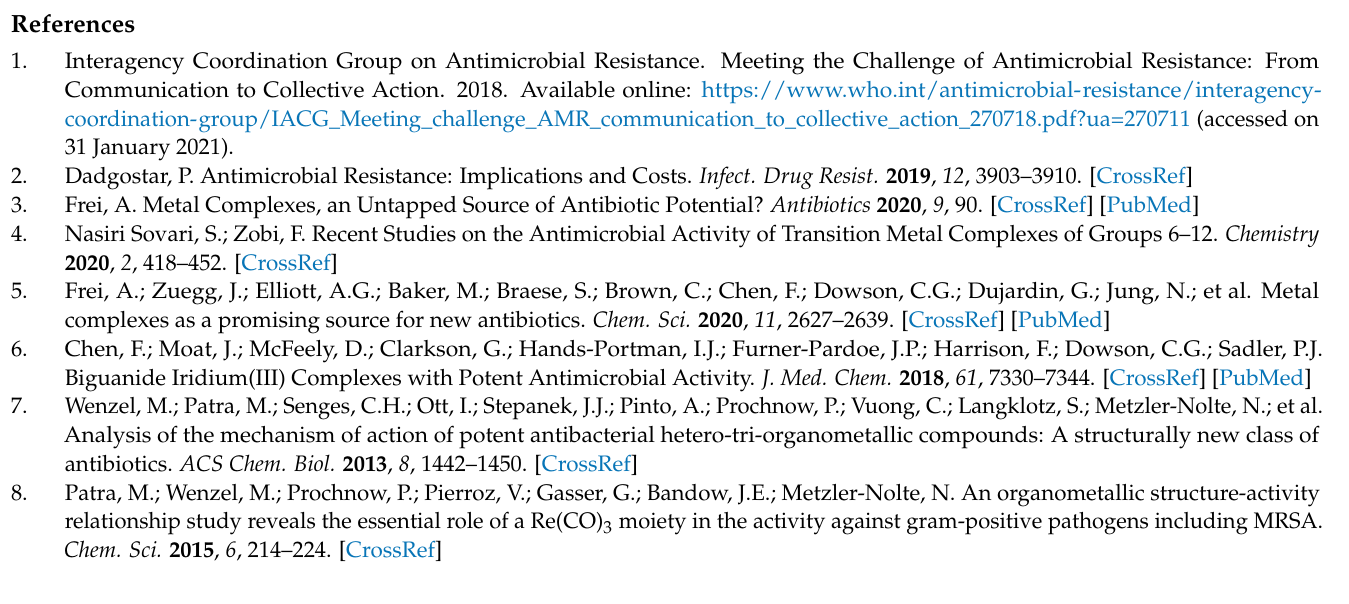
Figure S32: UV-Vis spectrum of [Re(CO) 3 (bpy)(O 2 CBz)] ( 10 ) in DMF, Figure S33: UV-Vis spectrum of ( 12 ) in DMF, Figure S35: UV-Vis spectrum of [Re(CO) 2 NO(bpy)(Me 2 N-py)](BF 4 ) 2 ( 9 ) in acetonitrile, Figure S36: UV-Vis spectrum of [Re(CO) 2 (NO)(bpy)F](BF 4 ) ( 6 ) in DMF, Figure S37: Emission spectra of selected nitrosyl Re complexes. Top: λ ex = 318; bottom λ ex = 350, Table S1: Crystal data